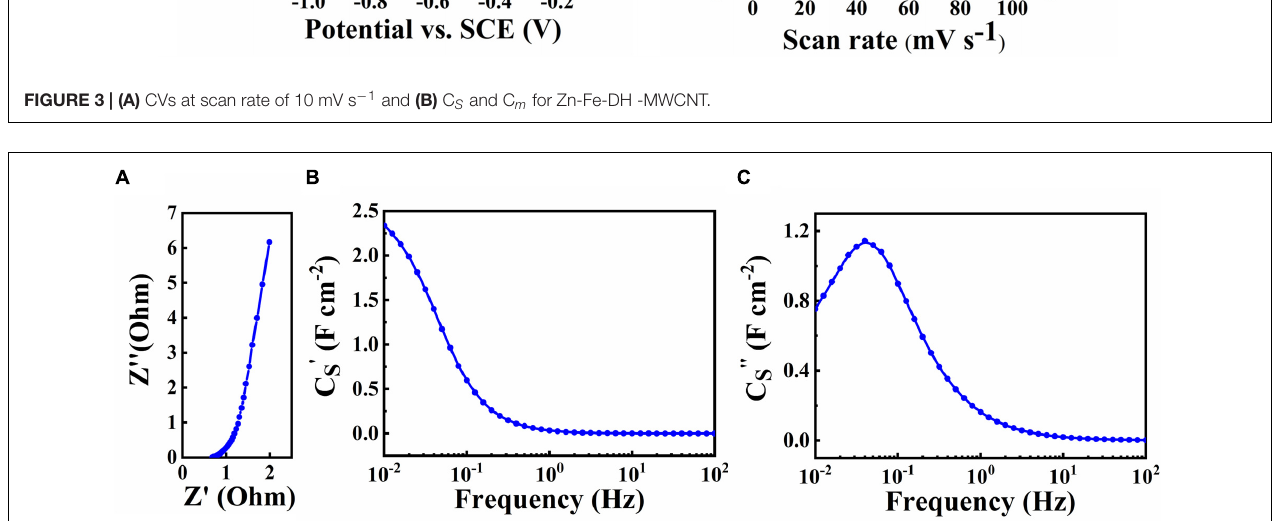
FIGURE 4 | (A) Nyquist plot of complex impedance and frequency dependences of complex capacitance components (B) Cs (cid:48) and (C) Cs (cid:48)(cid:48) for Zn-Fe-DH -MWCNT.